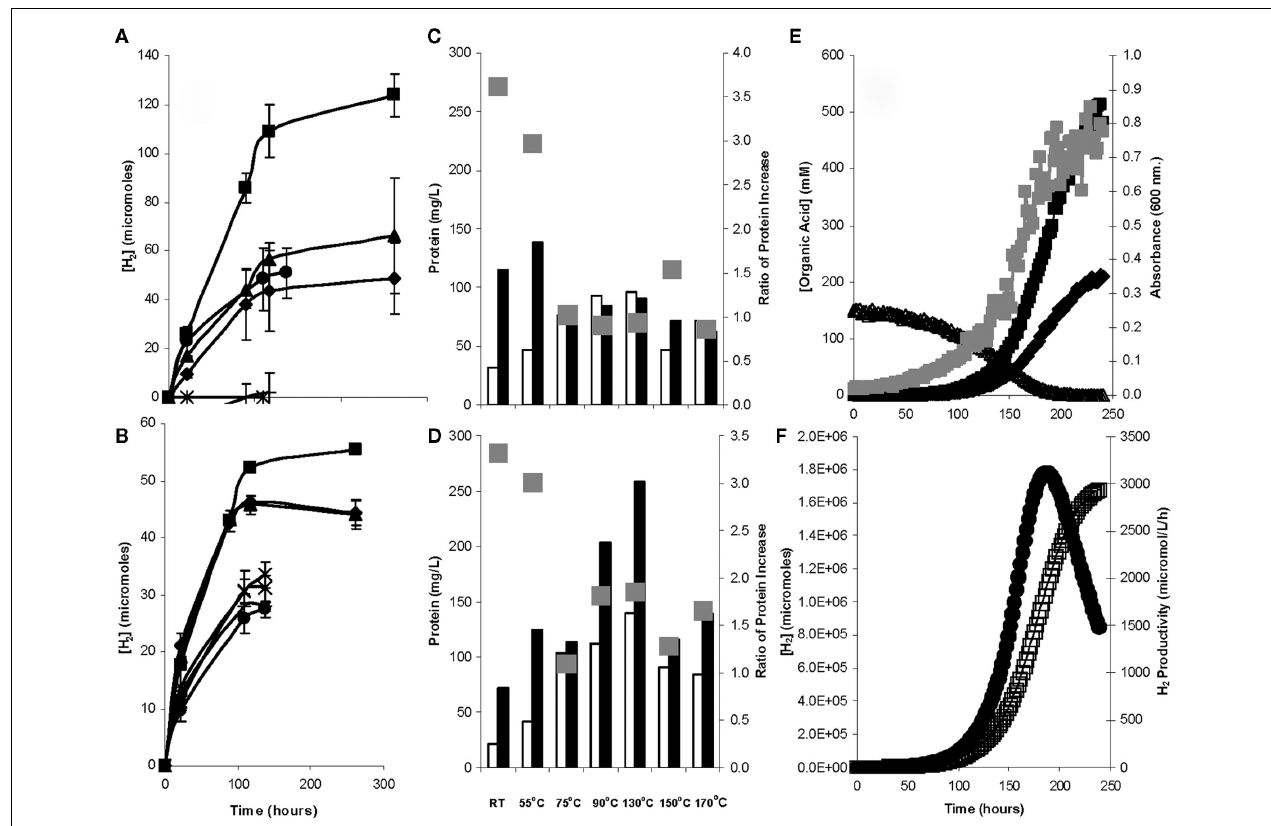
FIGURE 7 | Biohydrogen production from the hemicellulosic liquors of (A) switchgrass and (B) straw in serum grown H. hydrogenoformans. In each case a pretreatment of 55˚C ( (cid:6) ) yielded higher H 2 concentrations than those of room temperature ( (cid:2) ), 75˚C ( (cid:5) ), 90˚C ( × ), 130˚C ( ∗ ), 150˚( ( + ) . (C) switchgrass and (D) straw protein concentrations from incubations with the respective hydrolysate showing that the initial (white bar) protein